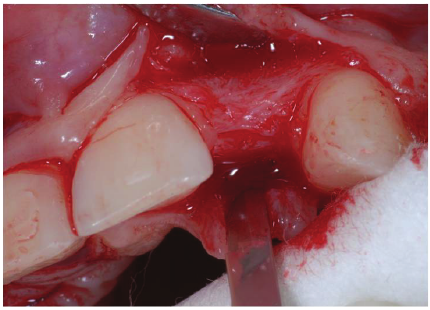
Figure 6: Crestal osteotomy and bone window creation in site to the right.